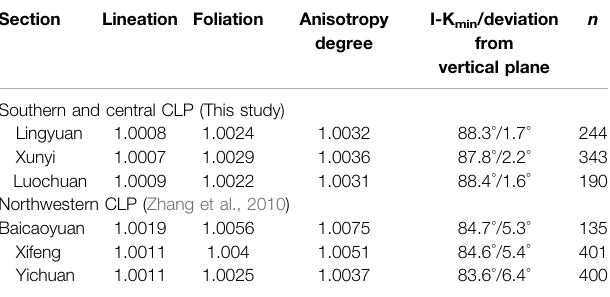
TABLE 1 | Descriptive parameters of the mean anisotropy of magnetic susceptibility used in this study.